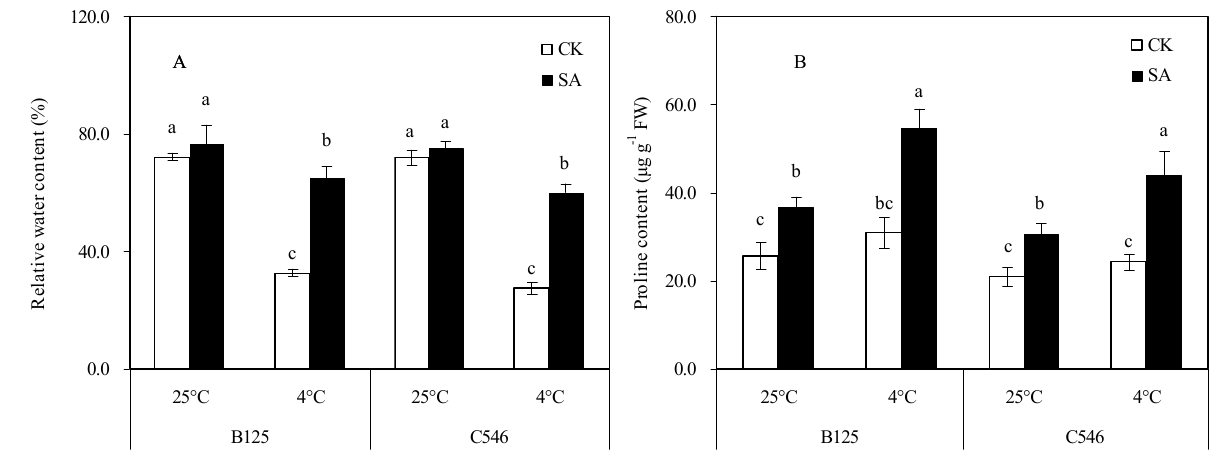
Figure 2. Effects of SA treatment on relative water content ( A ) and proline content ( B ) in C546 and B125 maize seedlings. The plants were treated at 4 °C for 2 days. The different letters indicate significant differences between different SA concentrations under two temperatures within the same inbred line at p < 0.05.